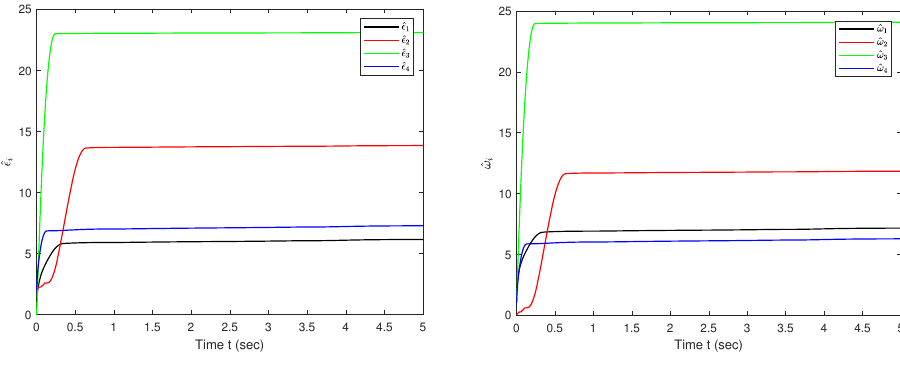
Figure 6. Dynamic control gain ˆ (cid:101) i and ˆ ω i , i =